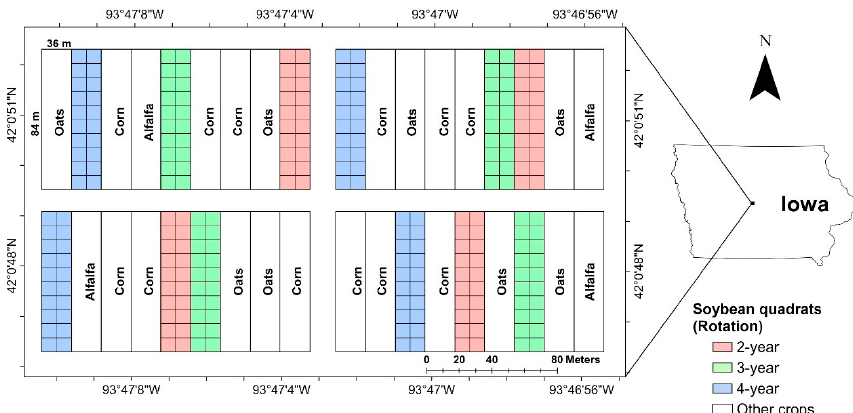
Figure 1. Experimental layout of the Marsden Farm located in Boone County, Iowa. The experiment was designed using a randomized complete block design with four blocks and each block has nine main plots. Each soybean plot was divided into 20 quadrats (8 m × 9 m, shown as square grids).